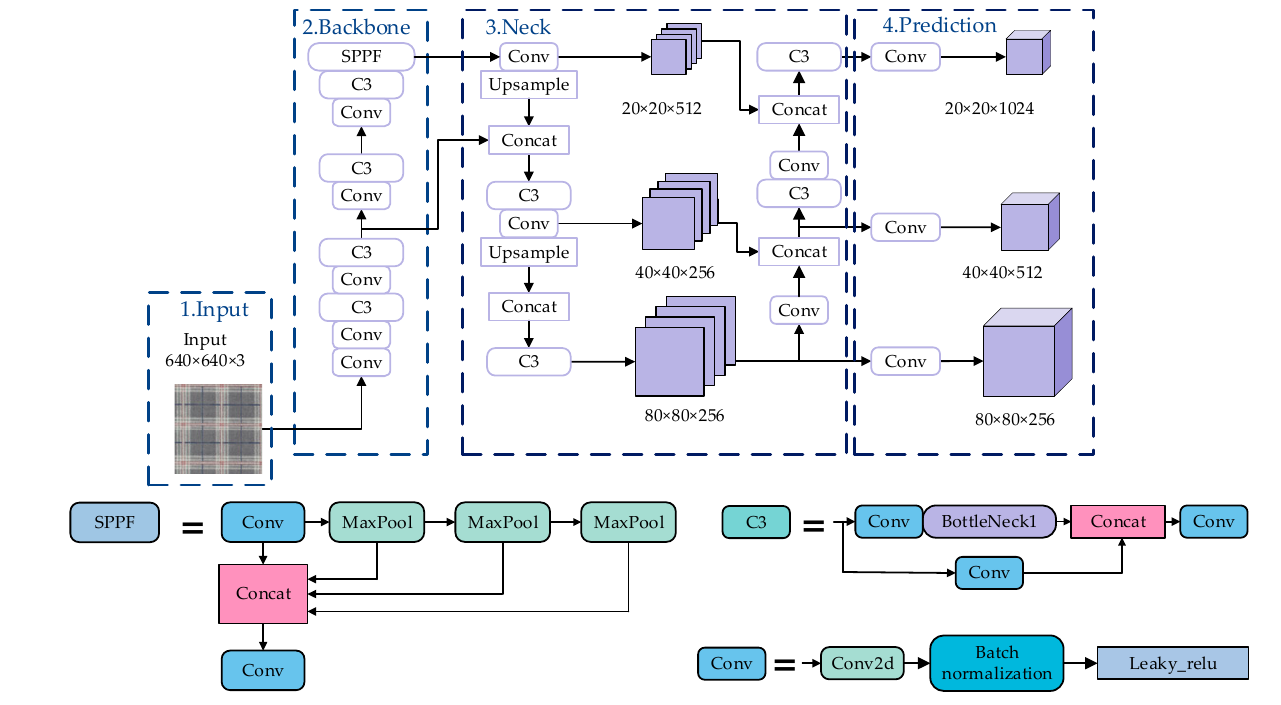
Figure 1. Network structure for YOLOv5.